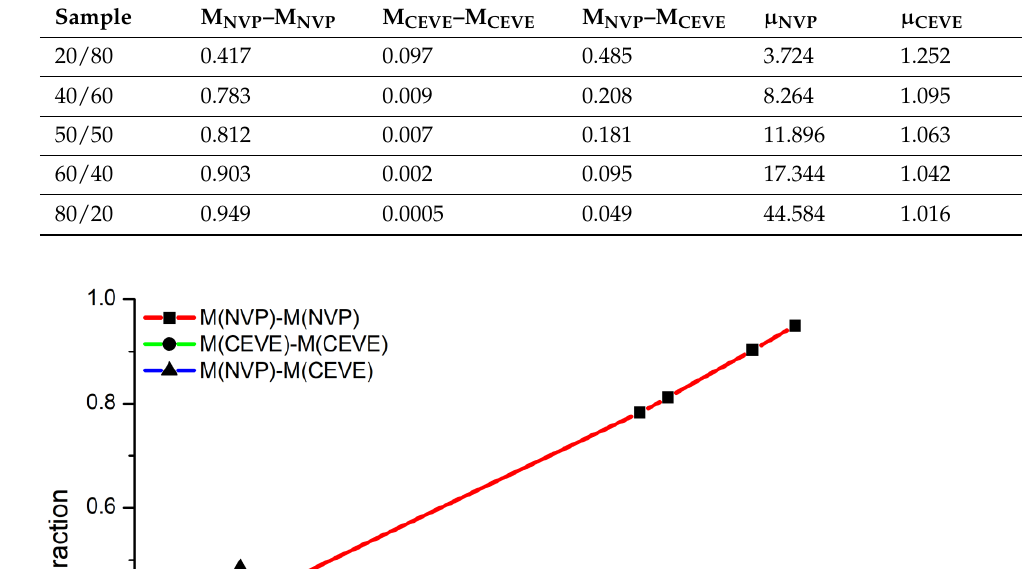
Table 4. Dyad sequence distribution and mean sequence lengths of NVP and CEVE in the copolymers. Sample